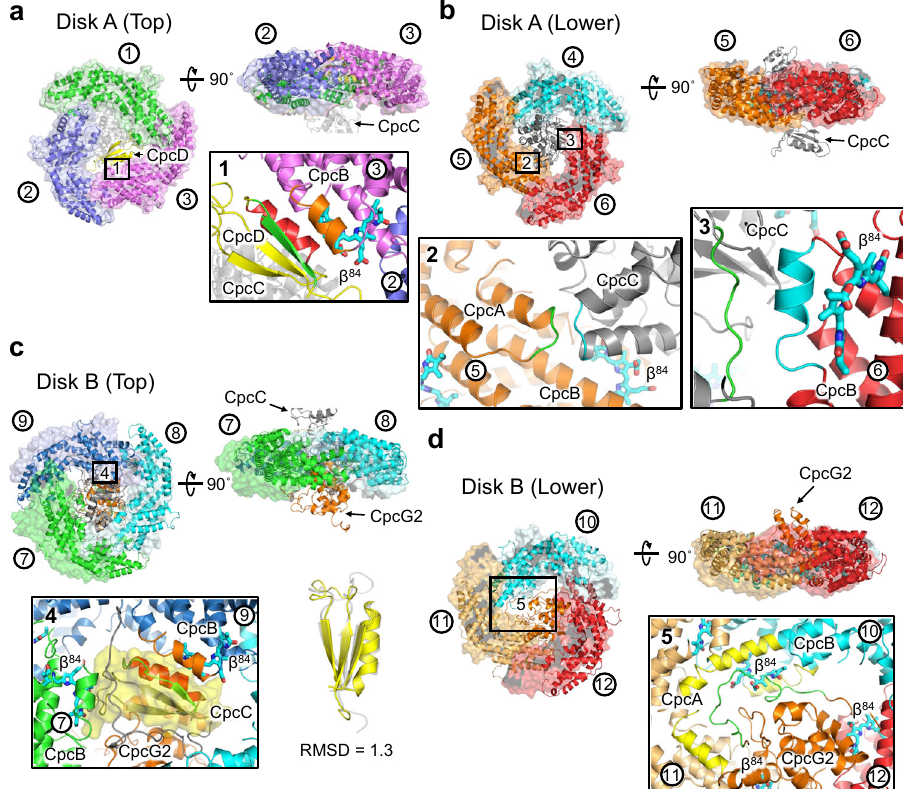
Fig. 7 Structural comparison of PC rods solved by cryo-EM (PDB: 7VEB) and X-ray crystallography (PDB: 3O2C). a Superimposition of the top parts of Disk A. The linker protein CpcD (residues 55 – 65 [red in “ panel 1 ” ] and 68 – 74 [green in “ panel 1 ” ]) interacts with a CpcB region (residues 109 – 122 [orange in “ panel 1 ” ]) in PC monomer 3. b Superposition of the lower parts of Disk A. The linker protein CpcC (residues 123 – 127 [cyan in “ panel 2 ” ] and 197 – 204 [green in “ panel 3 ” ]) interacts with CpcB regions (residues 14 – 17 [green in “ panel 2 ” ] of PC monomer 5 and 113 – 122 [cyan in “ panel 3 ” ] of PC monomer 6, respectively). c Superimposition of the top parts of Disk B. The “ CpcD-like structure (residues 234 – 287) ” in CpcC interacts with a CpcB region (residues 109 – 122, orange in “ panel 4 ” ) in PC monomer 9. The RMSD of the regions (residues 234 – 287) in CpcC and CpcD is 1.3. d Superposition of the lower parts of Disk B. The linker protein CpcG2 (residues 9 – 38 [green in “ panel 5 ” ]) interacts with regions in monomers 10 (residues 78 – 90 and 109 – 122 [yellow in “ panel 5 ” ]) and 11 (residues 1 – 15 and 105 – 115 [yellow in “ panel 5 ” ]). The areas marked “ 1 – 5 ” are the magni fi ed view of the interacting parts of the linker proteins and each PC monomer. Helix and transparent surface models represent PC rods solved by cryo-EM and X-ray crystallography, respectively. Panels 1 – 6 show magni fi ed views of the interactions of each PC trimer with the linker In addition, we superimposed the T. vulcanus PC rod and Nostoc 7120 PC rod (Rs1: PC rod containing CpcG2) for structural comparison (Supplementary Fig. 16 and Supplemen- tary Table 7). The overall structures are very similar, with the arrangement of Disk A and Disk B in the Nostoc 7120 PC rod